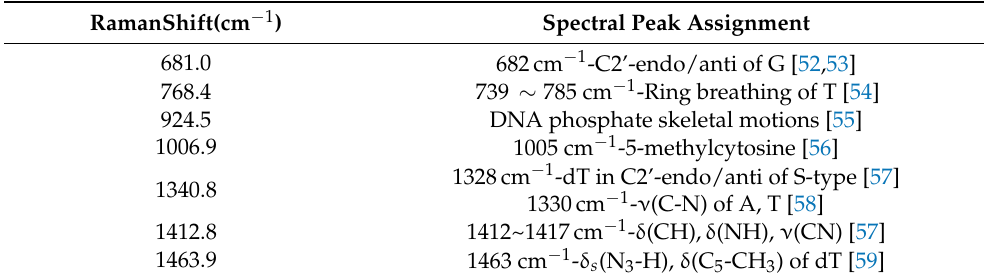
Table 1. Band positions and their assignments to spectra of plasmid